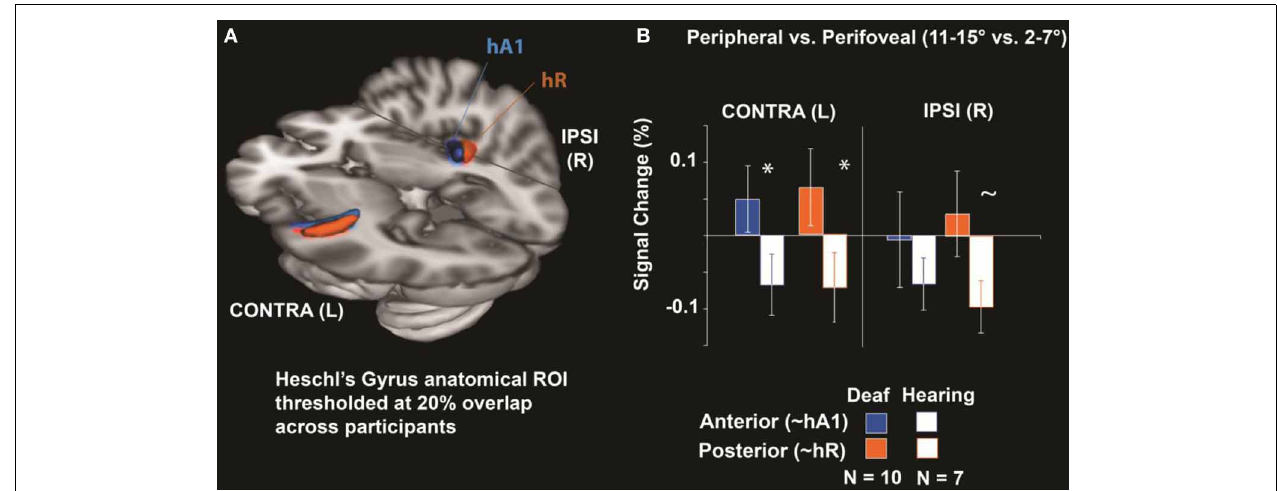
FIGURE 2 | Heschl’s Gyrus Region of interest analysis. (A) Anatomical Heschl’s gyrus ROIs drawn on individual structural brain images divided along the first principal component axis into an anterior and posterior subregion to approximate primate primary-auditory areas A1 and R respectively (as defined tonotopically in hearing adults; Da Costa et al., 2011), shown here thresholded at 20% overlap across participants.